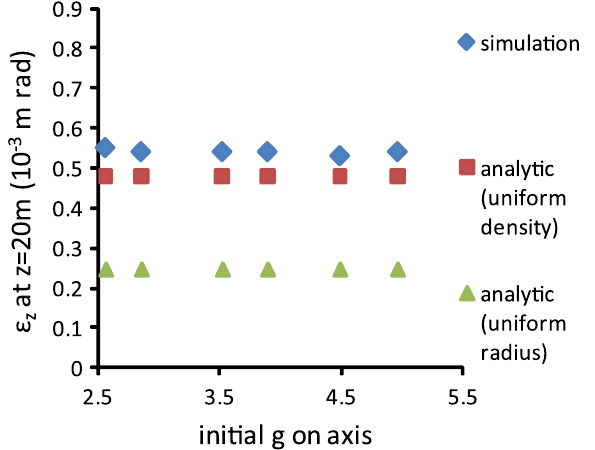
FIG. 16. z emittance at z ¼ 20 m ( (cid:1) 10 (cid:2) 3 ) vs initial geomet- ric factor on axis, showing 2 cases with uniform beam radius (red), uniform charge density (green), and WARP simulation (blue).